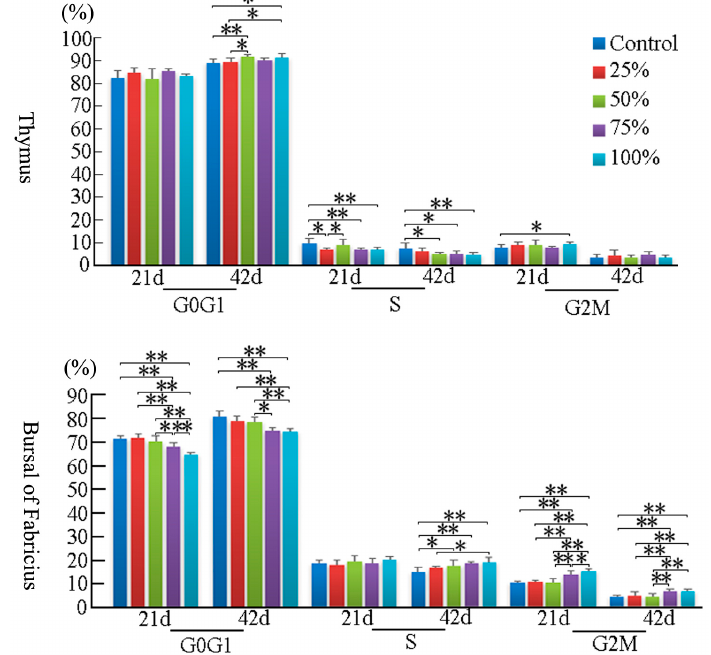
Figure 4. Effects of AFB-contaminated corn on cell cycle phase distribution of thymocytes and BF cells in chickens. ** represents the significant difference ( p < 0.01). * represents difference ( p < 0.05).